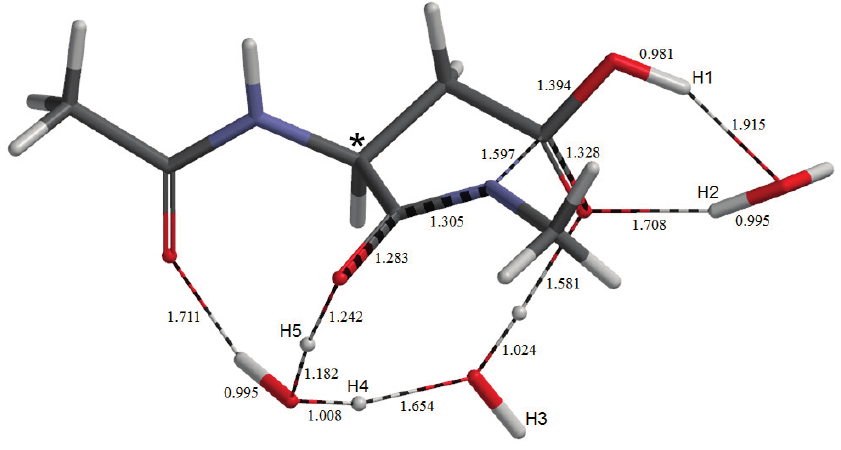
Figure 9. The geometry of the fifth-step transition state TS5 . Selected interatomic distances are shown in Å.